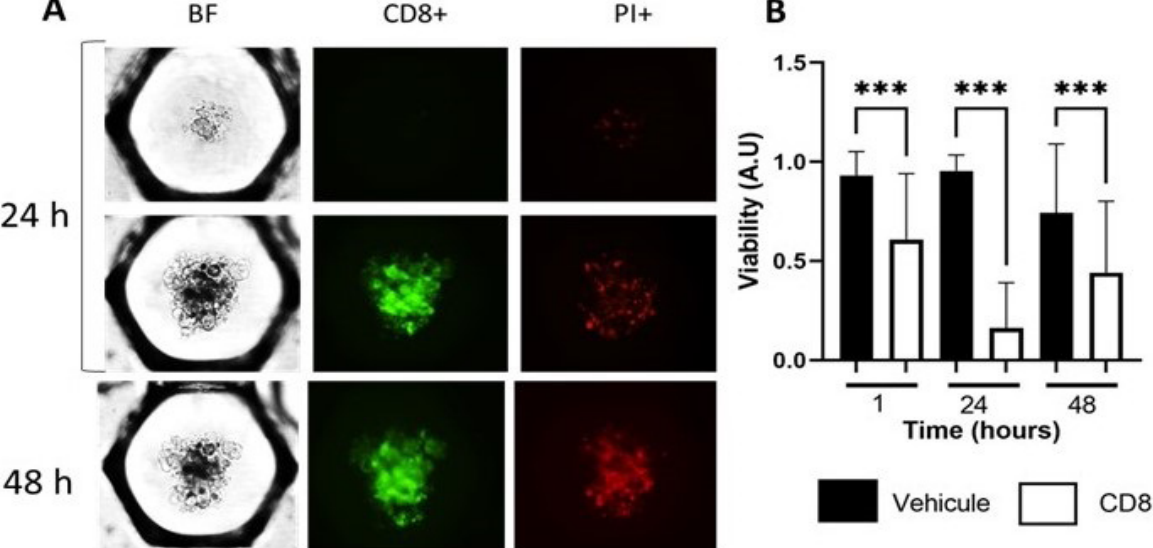
Figure 5. Quantifying CD8+ lymphocyte-induced cytotoxicity in primary ovarian cancer. A) Ovarian primary tumor cells with and without CD8+ at 24 h and 48 h, BF for the detection of the spheroids, CFSE (green) CD8+, 555 nm PI dead cells; B) boxplot of the viability with and without CD8+ at 1 h, 24 h and 48 h. Statistical analysis: two-way ANOVA.